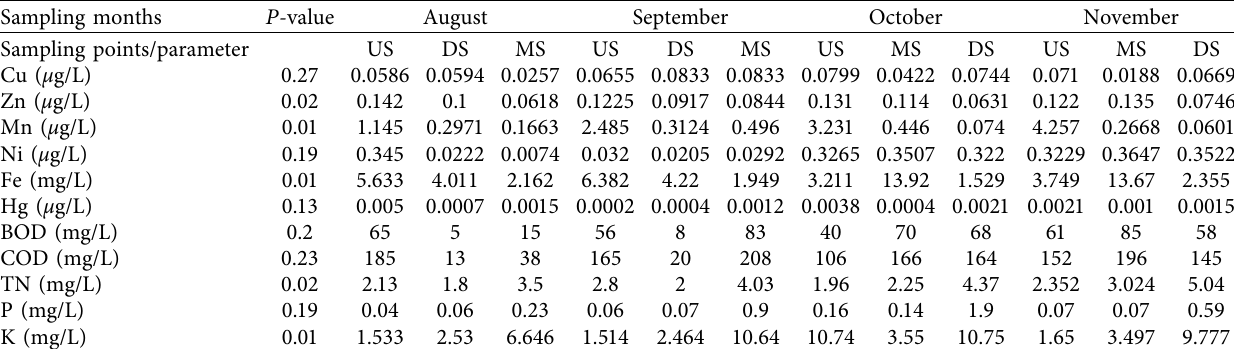
Table 4: Results of the various heavy metal parameters